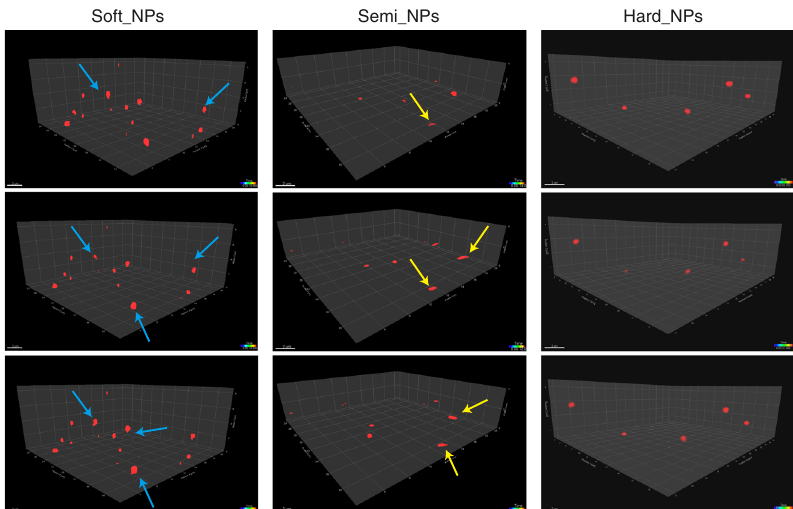
Fig. 6 Snapshots and trajectories of NPs in rat intestinal mucus, as imaged by Airyscan microscopy. Blue arrows represent soft NPs with irregular shapes. Yellow arrows represent semi-elastic NPs deformed into ellipsoids. The three scans for the soft, semi and hard NPs are similar. Scale bars: 2 μ m